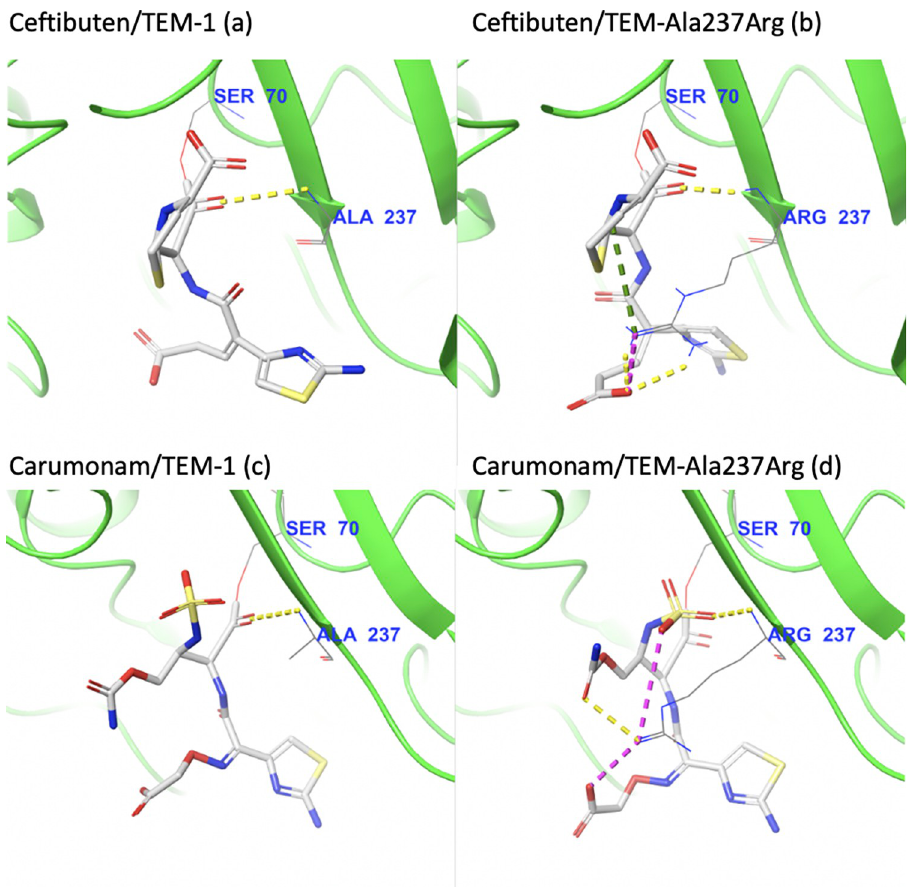
Fig 10. Visual inspection of the intermolecular interactions with key active site residue 237 for ceftibuten covalently bound to (a) TEM-1 and (b) TEM-Ala237Arg, and for carumonam covalently-bound to (c) TEM-1 and (d) TEM-Ala237Arg. Yellow dotted lines indicate hydrogen interactions, orange dotted lines indicate poor contacts/ clashes, purple dotted lines indicate salt bridges, and green dotted lines indicate cation-pi interactions.